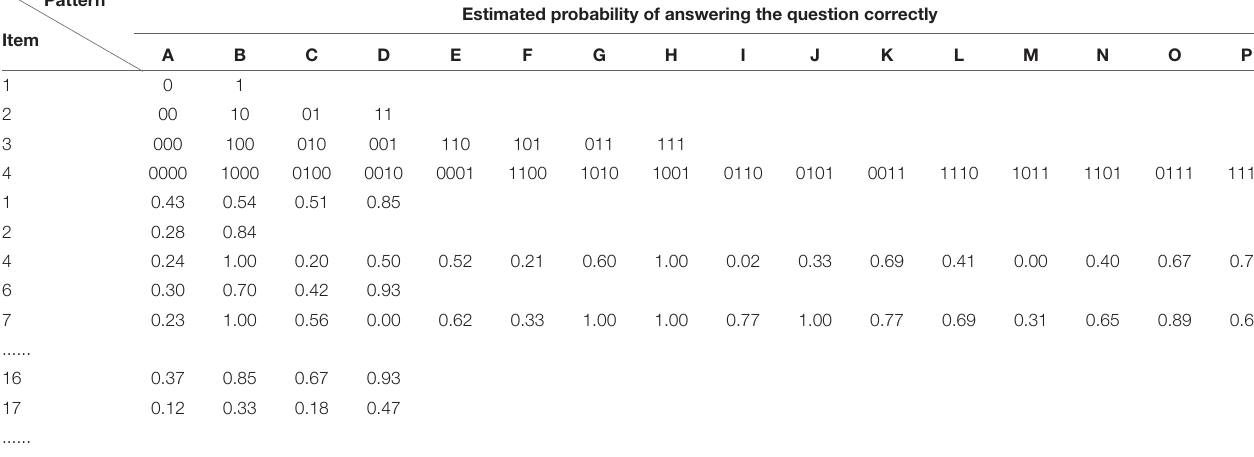
Estimated probability of answering the question